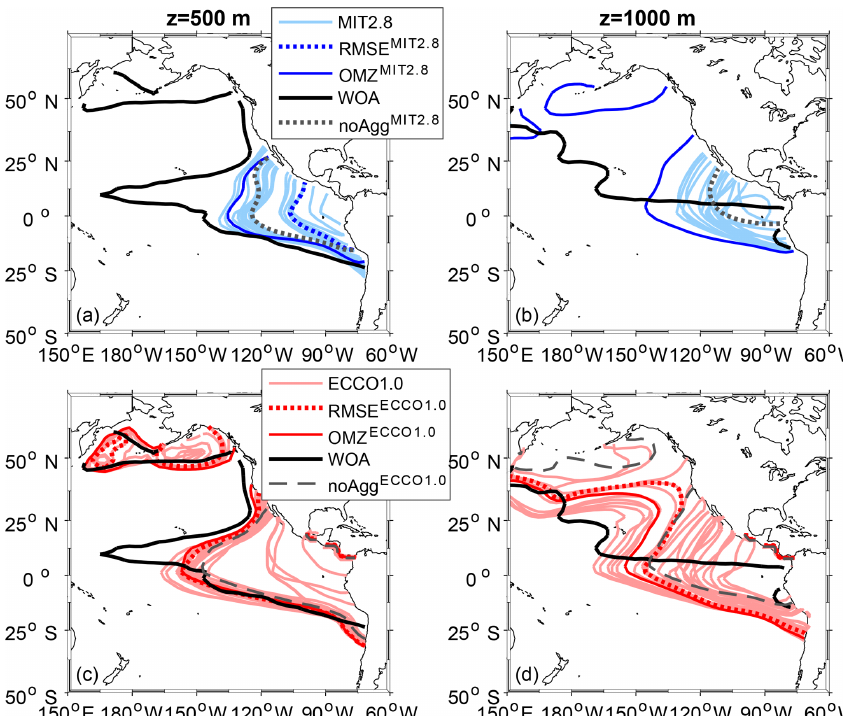
Figure 2. Comparison of Pacific Ocean OMZ (O 2 ≤ 50mmolm − 3 ) between model simulations and observations. Panels (a) and (b) show the OMZ at a depth of 500 and 1000m for the coarse resolution, MIT2.8, and panels (c) and (d) for the fine resolution,